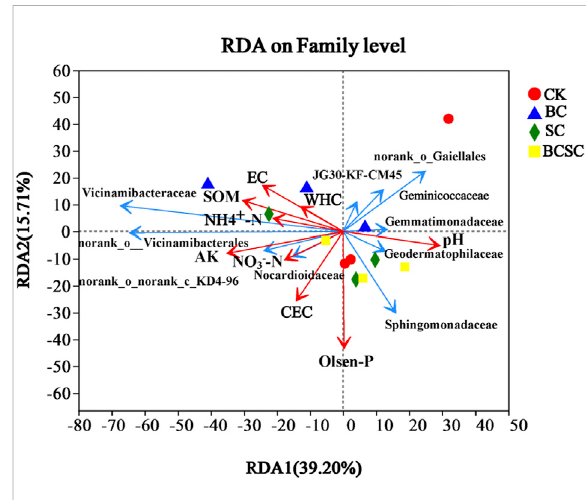
FIGURE 6 Redundancy analysis (RDA) of the relationship between the bacterial family (blue arrows) and soil properties (red arrows) for coastal soil. CK: soil without amendment; BC: soil amended with corn straw biochar at 1.0% (w/w); SC: soil amended with seaweed compost without biochar at 1.0% (w/w); and BCSC: soil amended with cocomposted biochar and seaweed at 1.0%